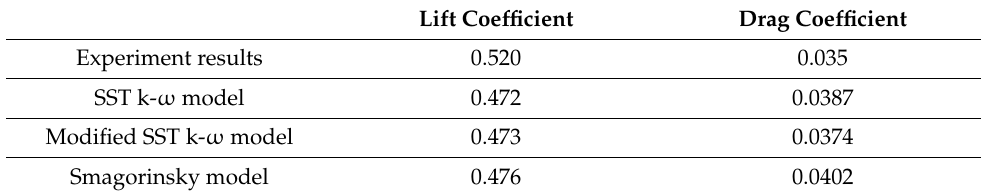
Table 4. Lift and drag coefficient in cavitation flow.